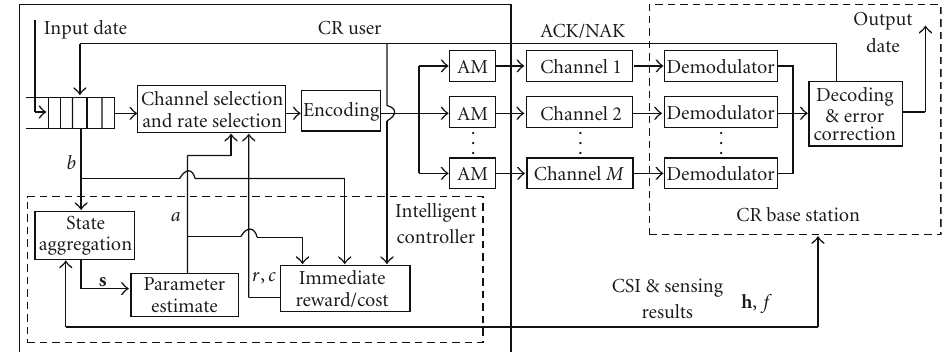
Figure 1: Transmission model.